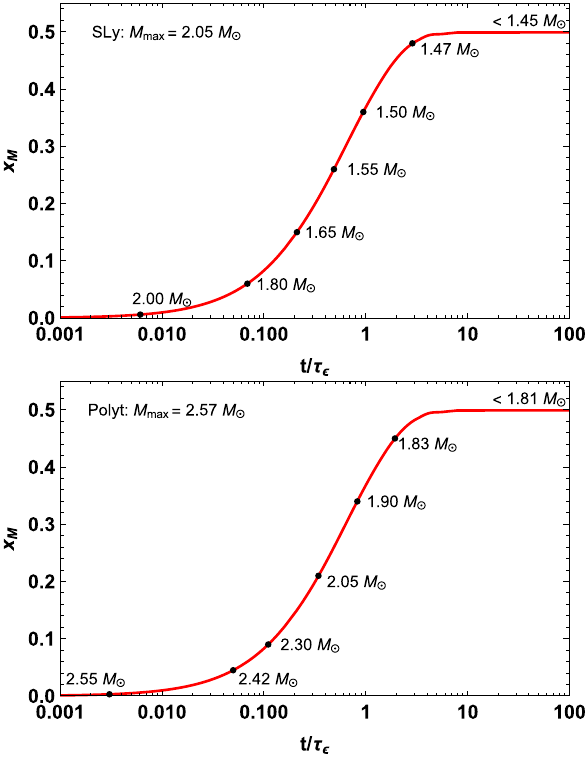
Fig. 4 Evolution of the mirror fraction X = N M / N in mixed stars as a function of time in units of τ ε = (cid:11) − 1 curves show the maximal possible mass of the MS at the corresponding age